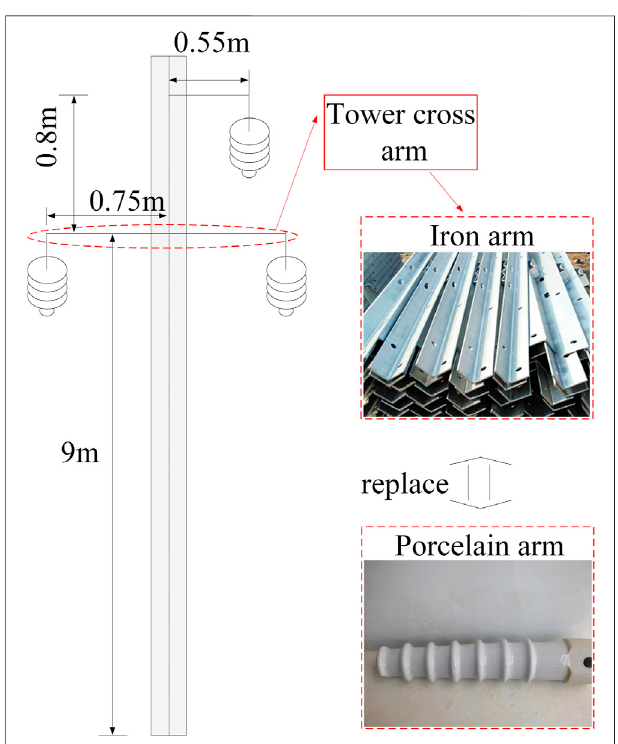
FIGURE 9 | Schematic diagram of replacing tower cross